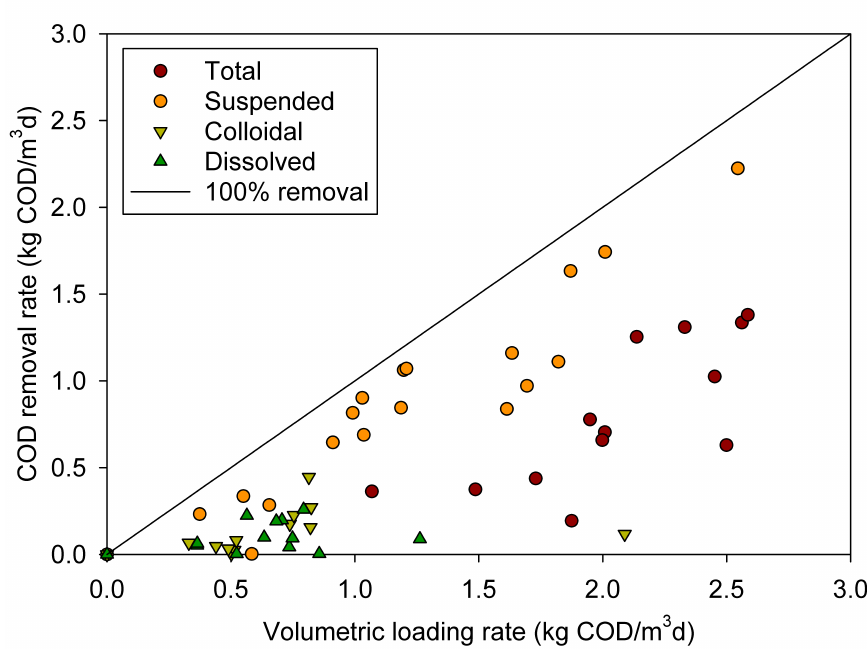
Figure 5. COD removal rate vs. volumetric loading rate in